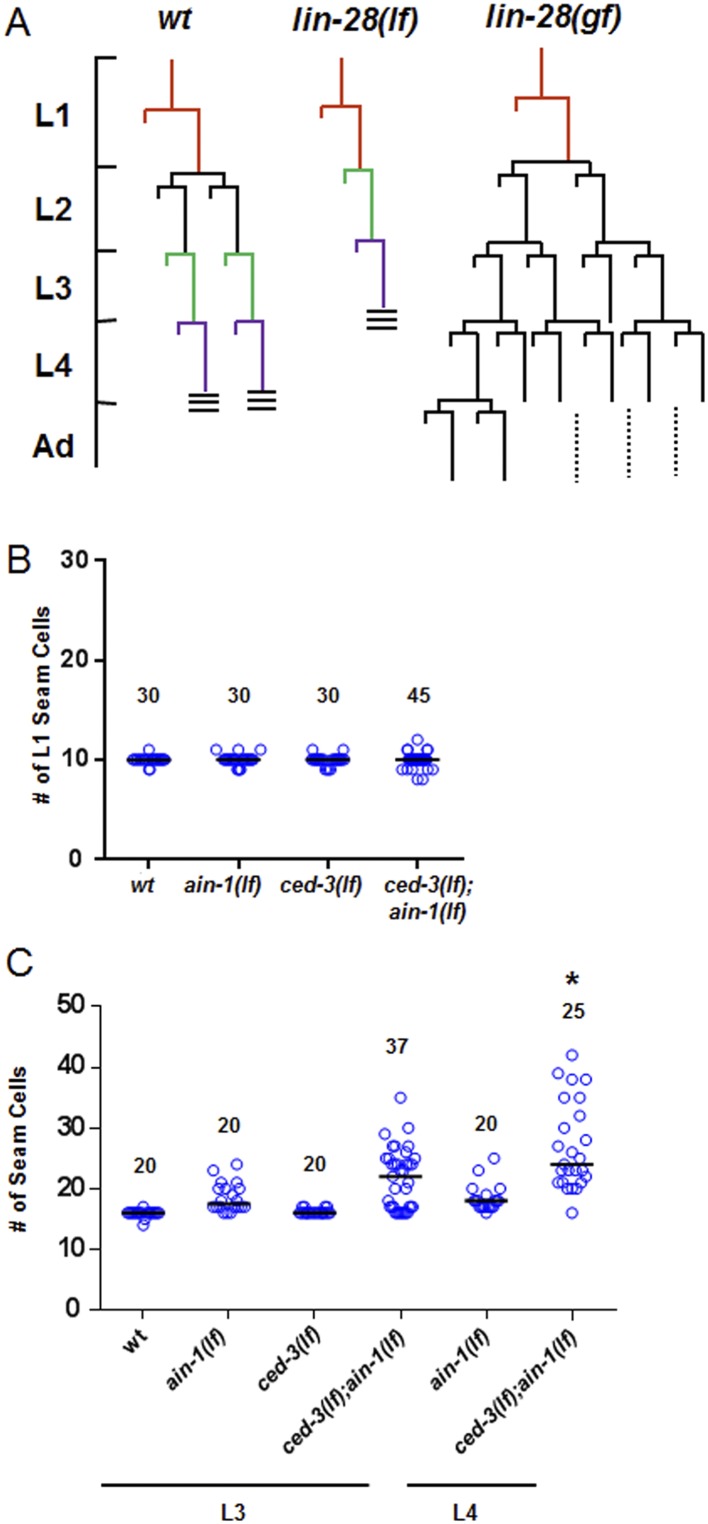
Additional analyses of seam cells for the ced-3(lf);ain-1(lf) double mutant.(A) Diagram depicting the symmetric and asymmetric cell divisions of V1–V4 and V6 lineages (based on content detailed in a recent review [Rougvie and Moss, 2013]). One cell is shown beginning at L1 (red). In wt, the L2 stage has a symmetric division followed by asymmetric divisions thereafter. The lin-28(lf) mutation generates a precocious phenotype without the L2-specific symmetric division; whereas, the lin-28(gf) mutation generates a retarded phenotype with further L2-like reiterations. Thus, a normal animal hatches with 10 seam cells that result in 16 terminally differentiated seam cells by adulthood. (B) The ced-3(lf);ain-1(lf) double mutant animals hatch with the correct number of seam cells which continue to develop during late larval stages. 10 seam cells are observed for all strains with no significant differences observed. Black bars indicate the median values for each strain (p > 0.05, Mann–Whitney test, all single and double mutants compared to wild-type). (C) Quantitation of third and fourth larval stages of the ced-3(lf);ain-1(lf) double mutant animals suggests supernumerary seam cells continue to arise during late larval stages. Black bars indicate the median values for each strain (p = 0.008, *compared to L3 stage ced-3(lf);ain-1(lf), Mann–Whitney test). The data shown for the L4 animals in panel (B) here are unique from the main Figure 6B and are not repeated.